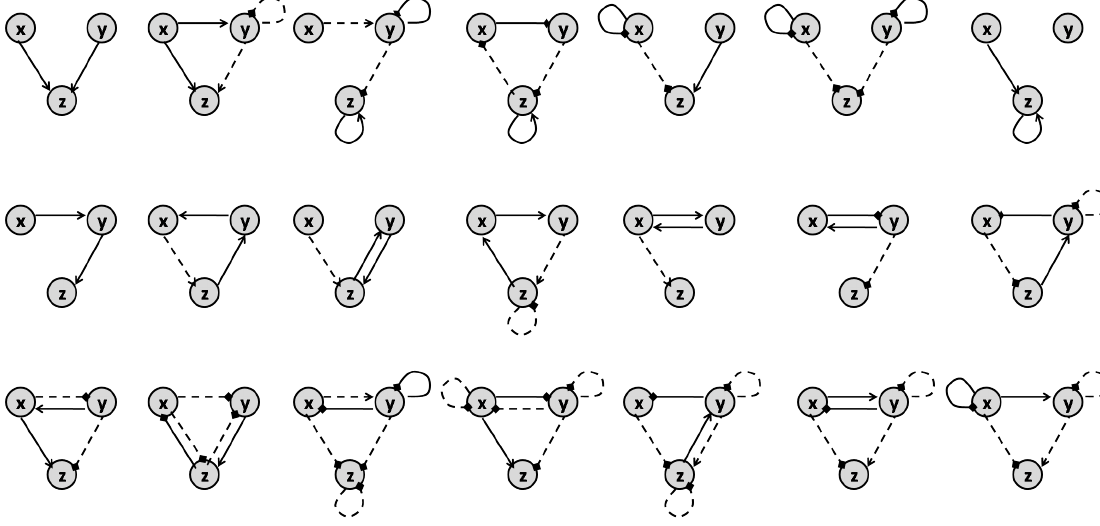
Figure 11. Set of the motifs that according to [41] leads to synergism for the combination of two drugs. Solid lines represent the drugs target links.